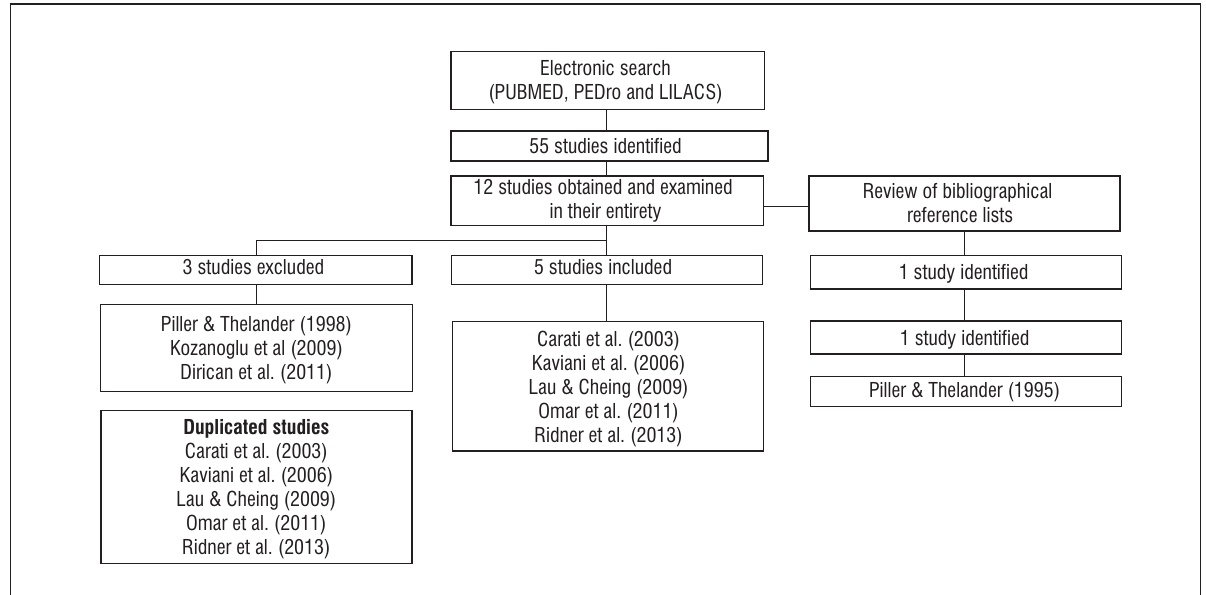
Figure 1 - Results of the database and manual search